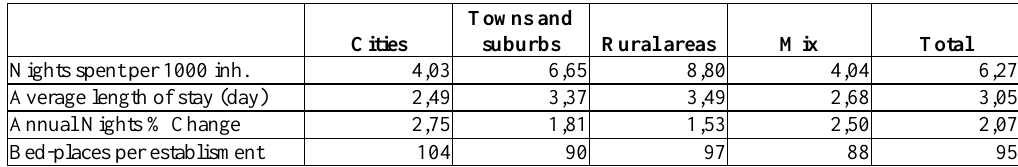
Figure 1: The Map of overnight stays in European Regions